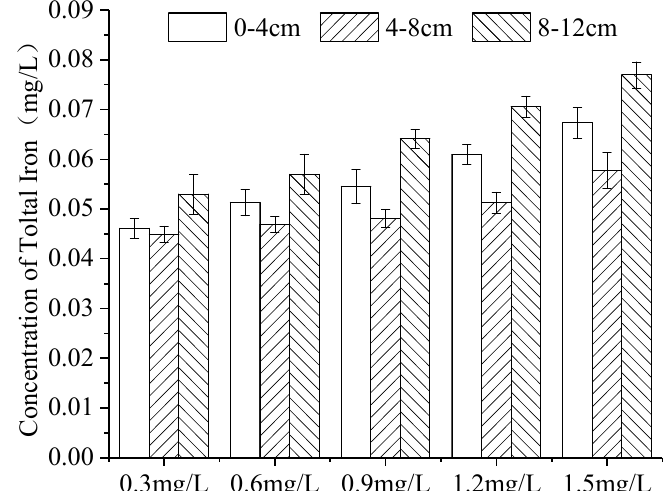
Figure 9. Distribution of iron with varying initial concentrations in the ice body. (Error bar: Mean ± S.D., K: the ratio of the average concentration of iron in the ice to that in the under ‐ ice water).